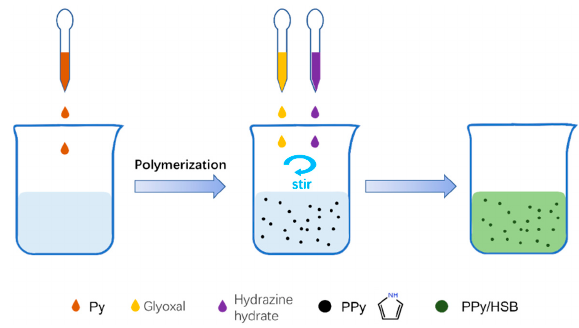
Figure 1. Synthesis route for the PPy/HSB composites.